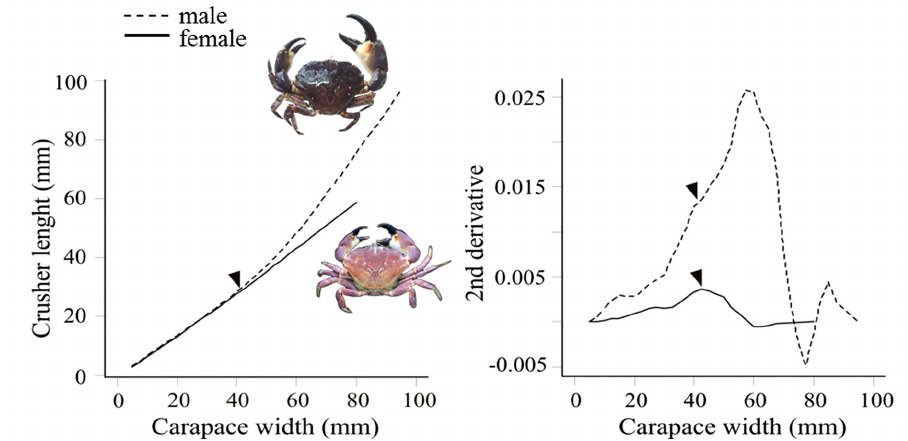
Fig. 6. – Sex differences in relative growth of the propodus length of the crusher chela of Platyxanthus crenulatus . Left: relative growth models estimated by the splines method and selected by general cross-validation; note the conspicuous crusher chela in the picture of the larger male. Right: the second derivative of the selected spline models. Males are in dotted lines and females in solid lines. Black arrows show the point at which relative growth rate diverges between